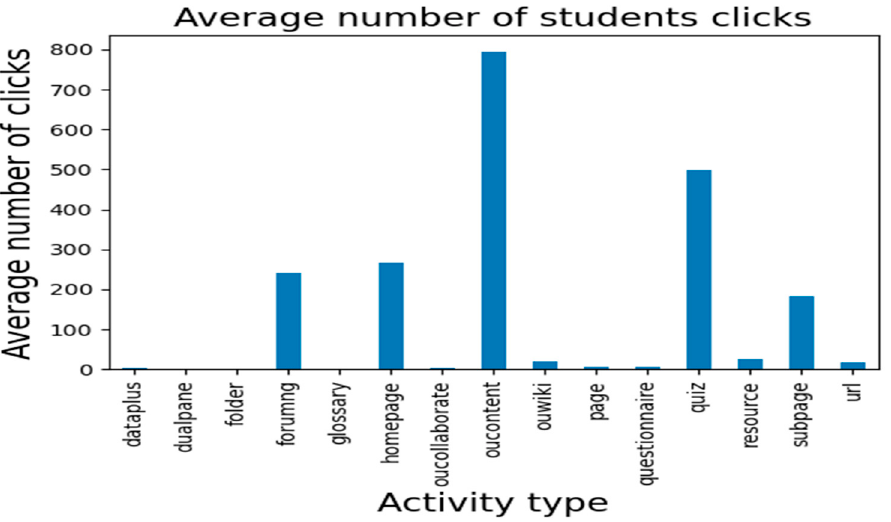
Figure 2. Student logins mean for each course activity.